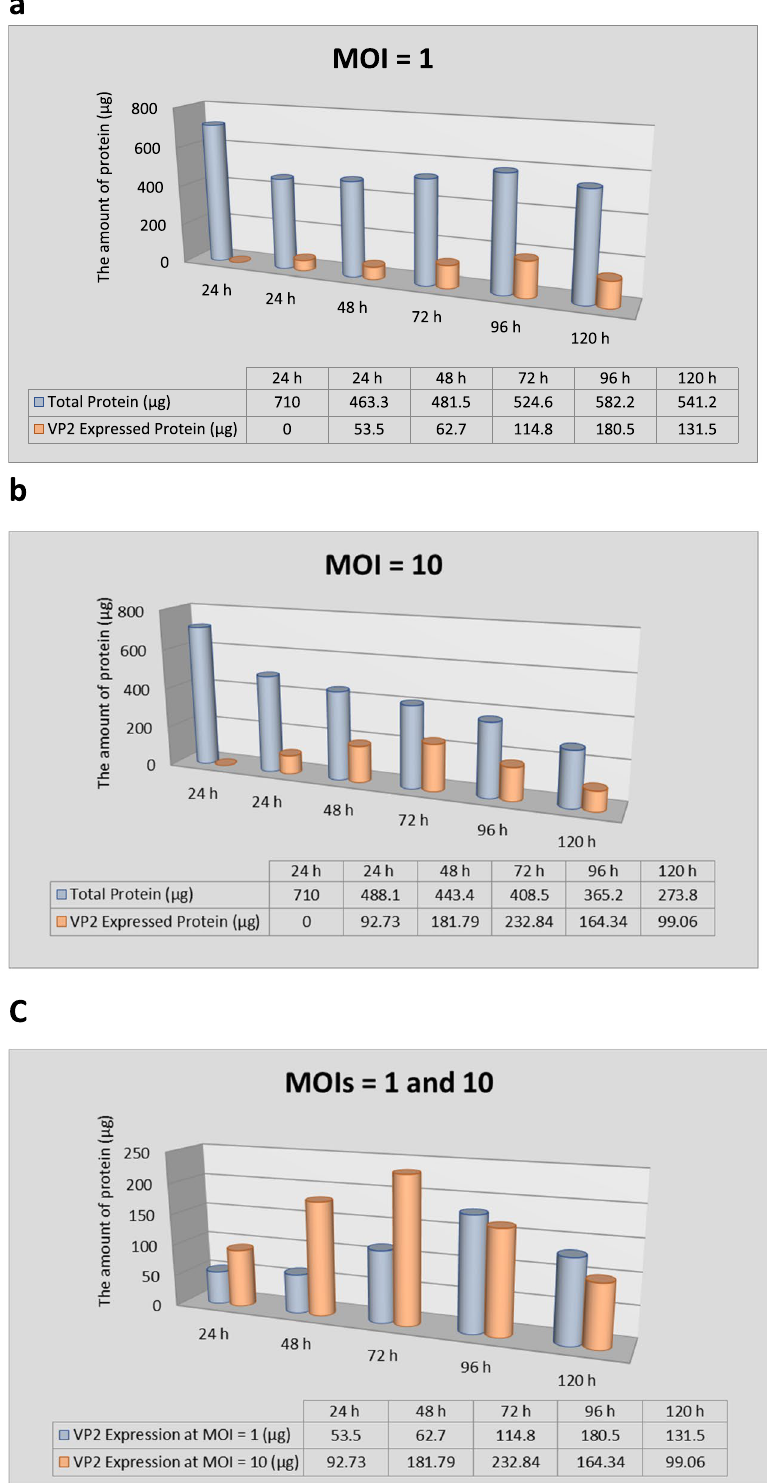
Fig. 4 (See legend on previous